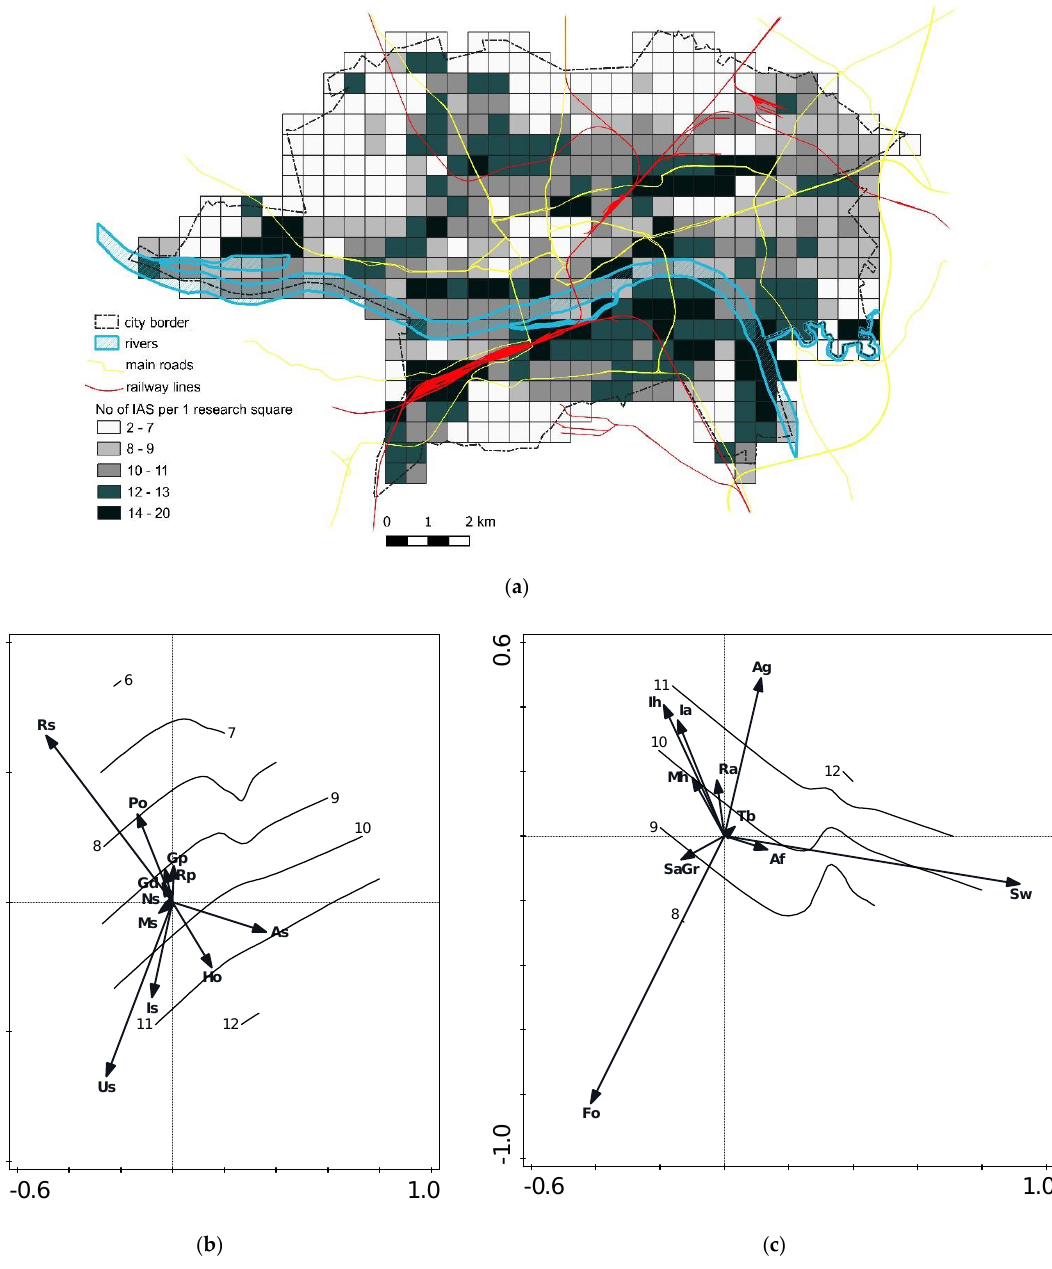
Figure 3. Species richness models: ( a ) spatial IAS number in permanent plots, only species noted within city borders are included; ( b ) loess model of species number (isolines) in the gradient of soil types based on redundancy analysis (RDA); ( c ) loess model of species number (isolines) in the gradient of soil types based on redundancy analysis (RDA). Abbreviations of urban soil types and habitat types as in Table 1.